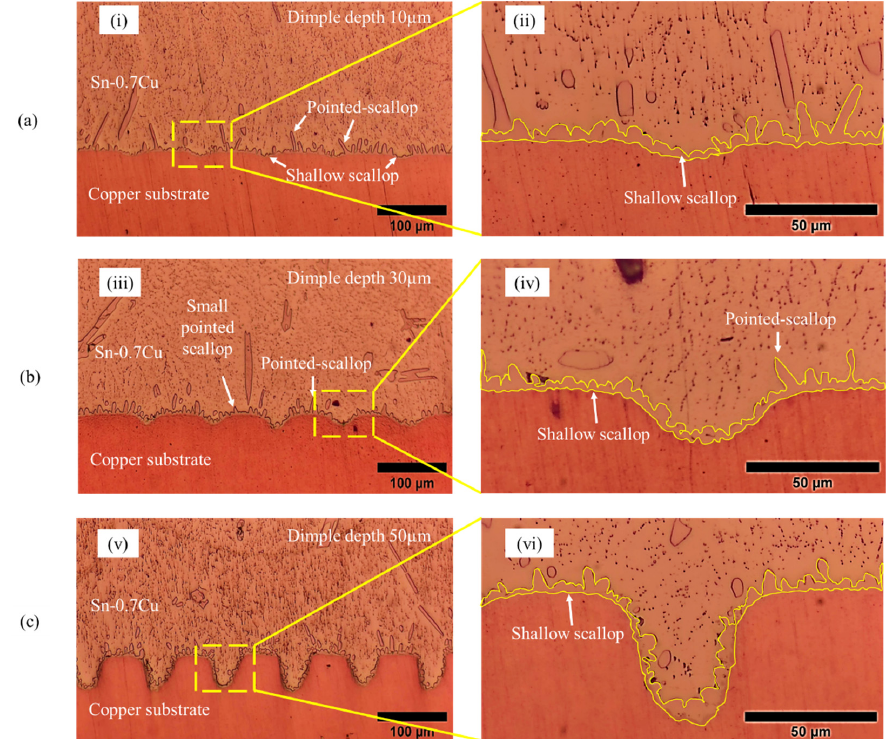
Figure 8. Micrograph of interfacial IMC layer on microtextured copper substrate with a dimple depth of ( a ) 10 µm, ( i ) magnification of 10×, ( ii ) magnification of 40×; ( b ) 30 µm, ( iii ) magnification of 10×, ( iv ) magnification of 40×; and ( c ) 50 µm, ( v ) magnification of 10×, ( vi ) magnification of 40×. The IMC thickness was averaged to determine the difference in the growth of IMC layers among dimple-microtextured copper substrates, and the results are shown in Figure